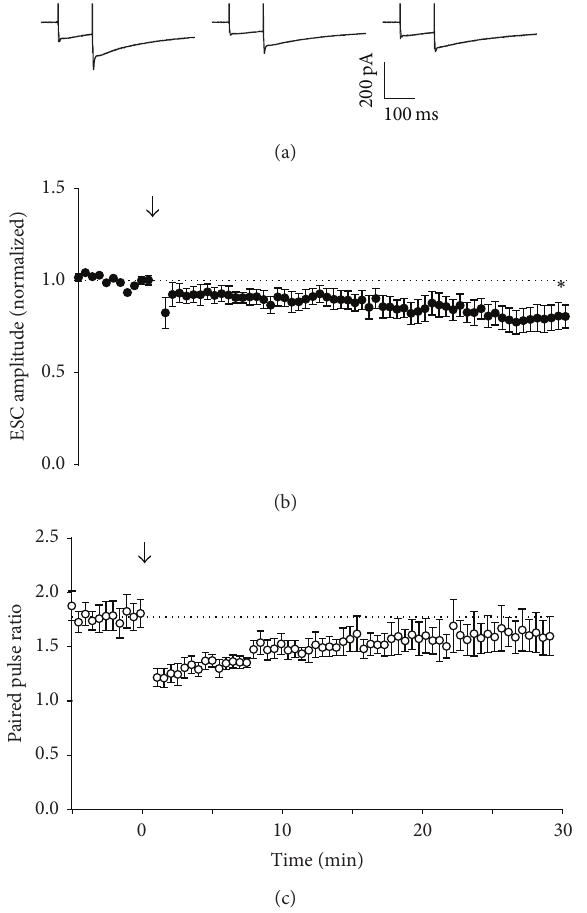
Figure 3: Effect of 16Hz tetanic stimulation on Bergmann glial responses in the presence of presynaptic receptor antagonists. Slices were preincubated with a cocktail of presynaptic receptor antagonists (2 𝜇 M DPCPX, 10 𝜇 M CGP 52432, 100 𝜇 M MPPG, and 5 𝜇 M SR141716) for 10 minutes prior to RFS and then for the 30 minutes following RFS. (a) Representative whole-cell recordings of ESCs generated by paired pulse stimulation (100ms interval) of parallel fibres in transverse cerebellar slices at 0.033 Hz before (first panel), immediately after (second panel), and 30 minutes after (third panel) raised frequency stimulation (RFS, 16Hz, 15s). (b) Time course of RFS effect on amplitude of the first pulse in each pair, with RFSdeliveredat 𝑡 = 0 ,indicatedbythearrow.Dataaremean ± s.e.m. from 4 cells. ∗ 𝑃 = 0.0192 , one-sample 𝑡 -test. (c) Time course of RFS effect on paired pulse ratio after tetanic stimulation at 𝑡 = 0 . Data are mean ± s.e.m. from 4